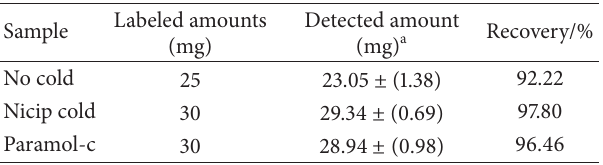
Table 1: Determinations of caffeine in pharmaceutical tablets using CV. Labeled amounts Detected amount Sample Recovery/% (mg) (mg) a No cold 25 23.05 ± (1.38) 92.22 Nicip cold 30 29.34 ± (0.69) 97.80 Paramol-c 30 28.94 ± (0.98) 96.46 a Mean value ± standard deviation ( 𝑛 = 5